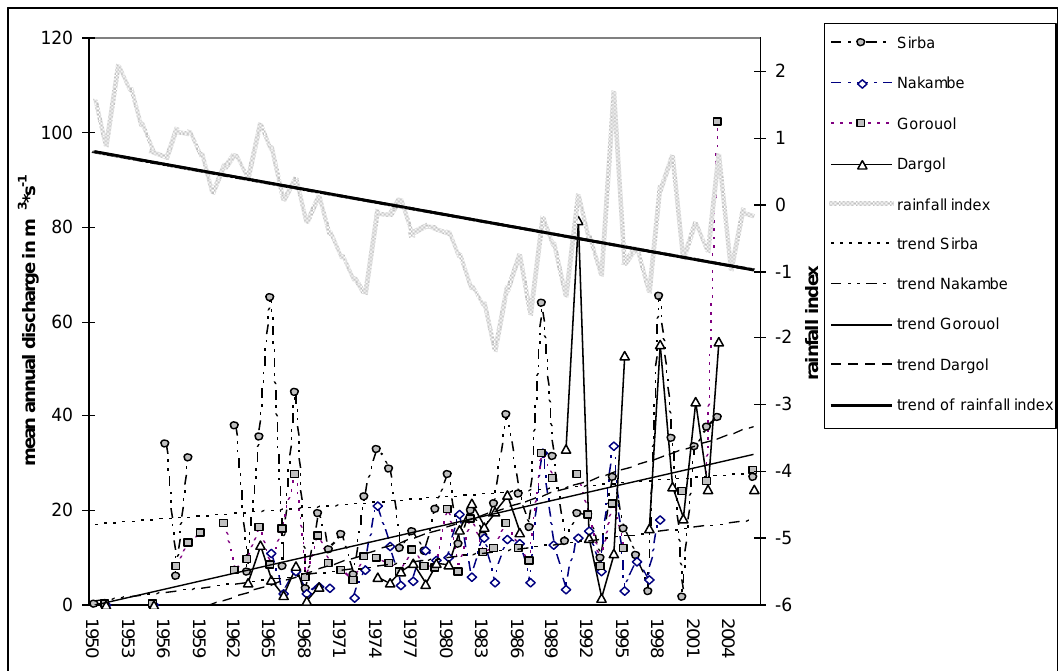
Figure 8. Average yearly total discharge of the three main ―Sahelian‖ tributaries of the Niger River in its middle reach from 1955 to 2006. The increase trend is lower for the Sirba River than for the other two; but it is real in spite of the decreasing rain fall, as evidence of the significant increase in runoff